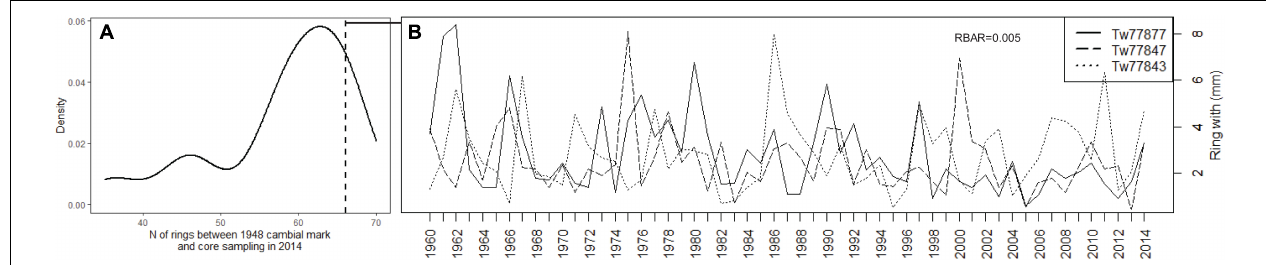
FIGURE 3 | (A) Distribution with number of rings formed in P. balsamifera between 1948 and 2014 (data from Hubau et al., 2019) where (B) cores with annual rings were retained and ring series were plotted with the crossdating parameters showing the lack of inter-series correlation. Rings before 1960 were removed to avoid effects of wound